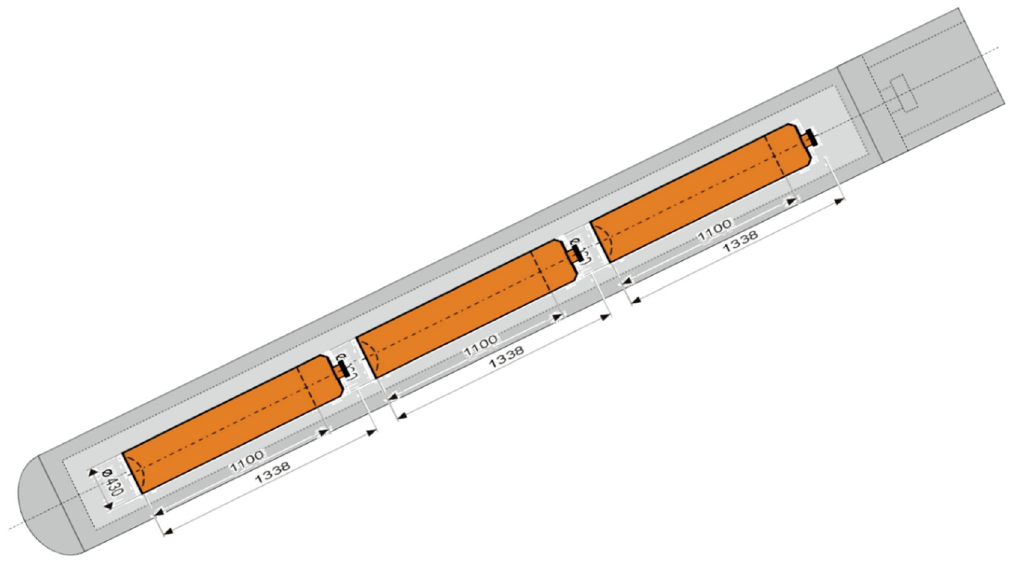
Figure 5. Sketch of the proposed container for deep borehole disposal.